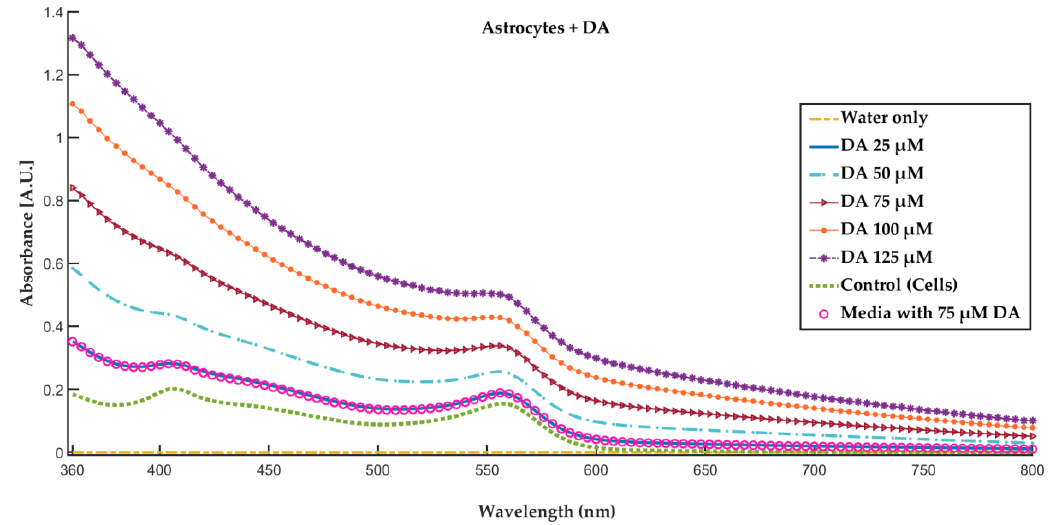
Figure 10. Ultraviolet-visible (UV-Vis) spectrum of water, control, and astrocyte media with different DA concentrations in the presence of cells (astrocytes). The results show the increase in the absorbance intensity with the increase in the polymerization of DA to PDA. Control = cells without added DA. DA concentrations indicate absorbance measured in the presence of cells, except for media alone with 75 µM DA (open circles), which was measured under conditions without cells present.